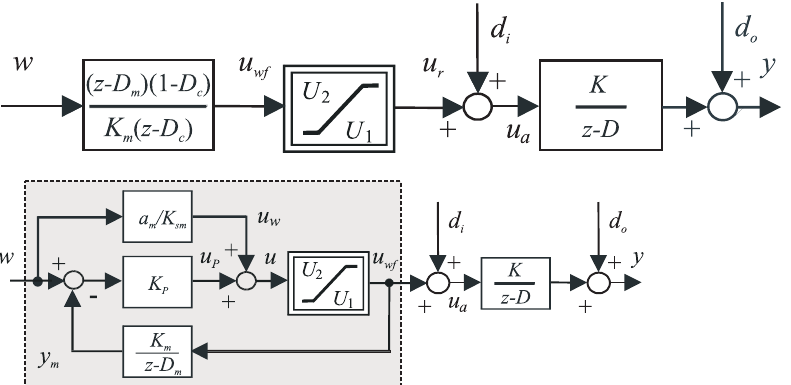
Figure 7. Constrained setpoint feedforward implemented by the single transfer function (12) (with the nominal plant S 0 ( z ) (Equation (4)) replaced by the model (3), above) and by the primary loop with 2-DoF P control